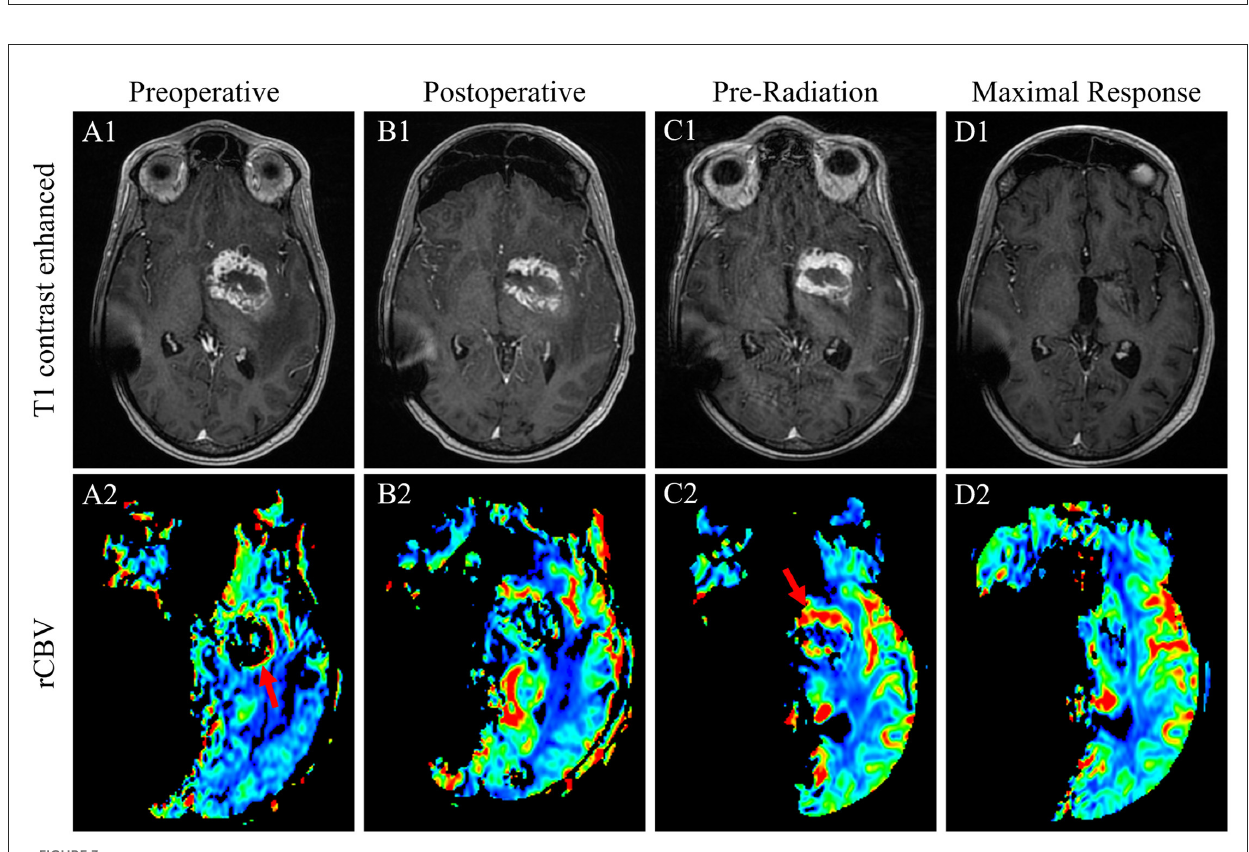
FIGURE3 T1-weighted contrasted sequences (1) and relative cerebral blood volume MRI sequences of case 2 patient’s GB at the time of initial diagnosis (A) ; immediate postoperative results following a subtotal resection (B) ; 1-month postoperative results prior to the initiation of radiation with evidence of substantial persistent disease with the evidence of interval progression (C) ; and the time of maximal response in the brain with complete disease remission 7 months after the conclusion of radiation therapy (D)